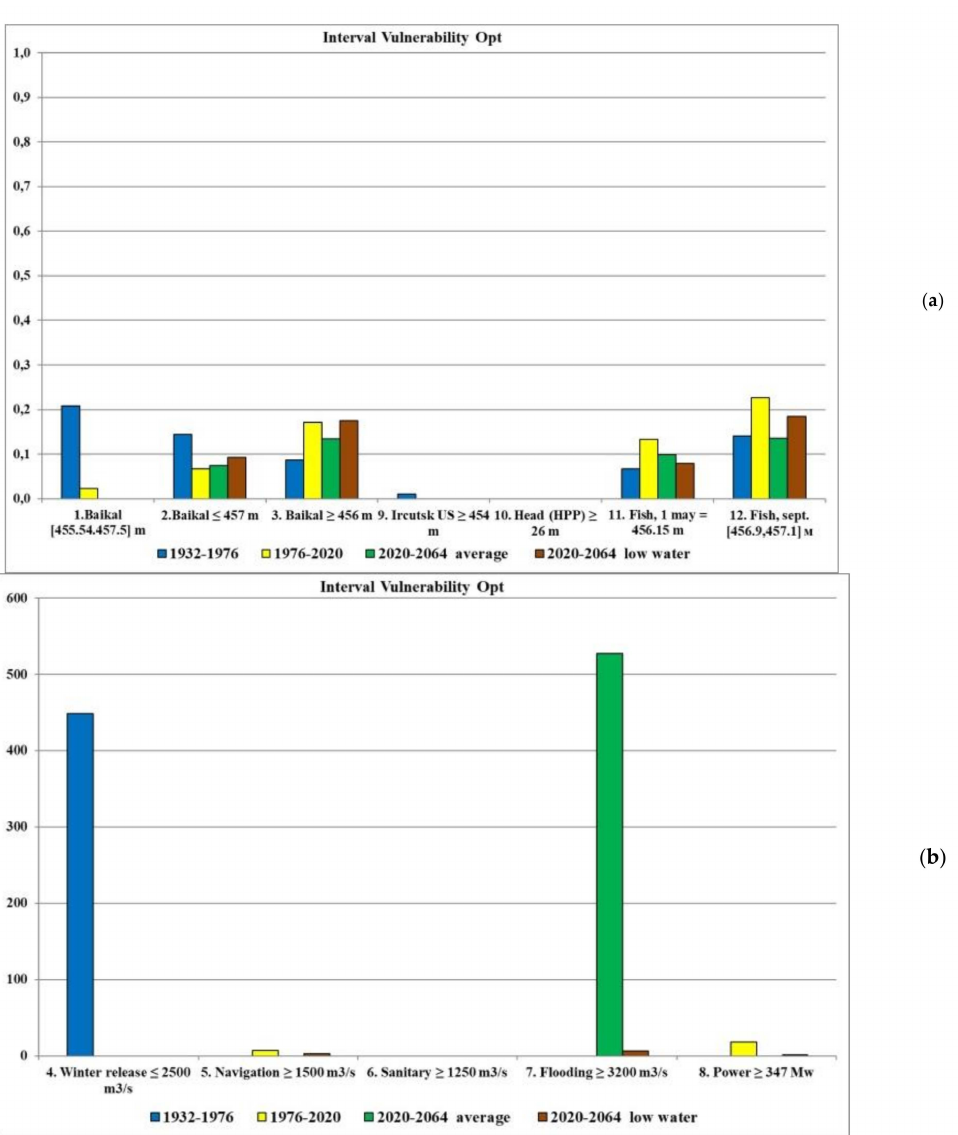
Figure 16. The vulnerability for different time series (optimization methods) for criteria 1, 2, 3, 9, 10, 11, 12 ( a ) for criteria 4, 5, 6, 7, 8, ( b